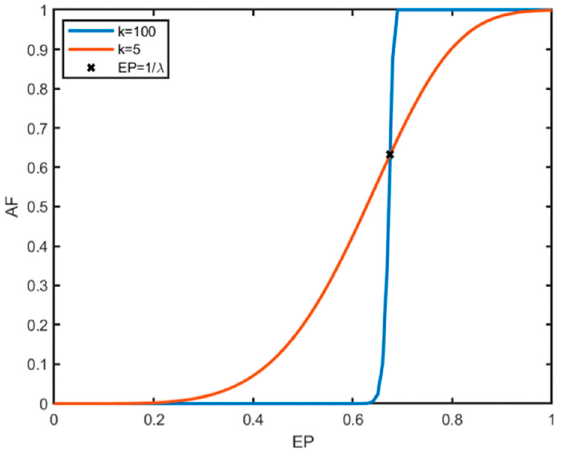
Figure 2. Pinch-o ff characteristics relating to k . Figure 2. Pinch-off characteristics relating to k. Figure 2. Pinch-off characteristics relating to k.